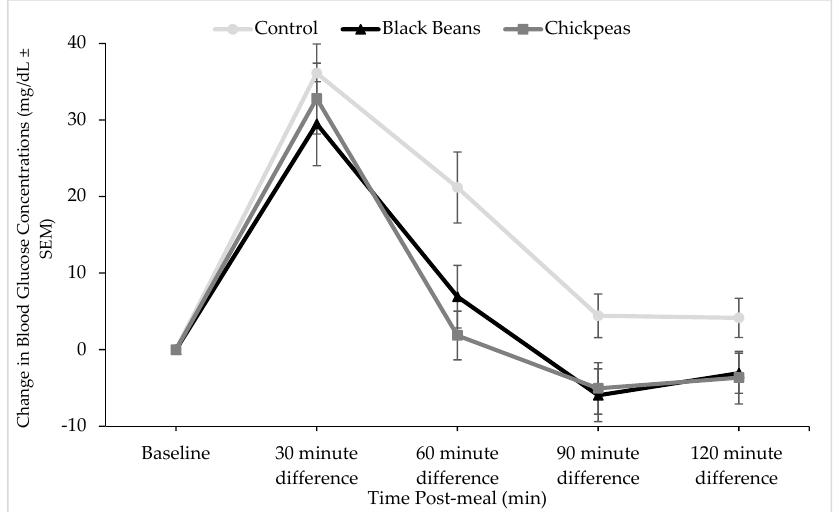
Figure 1. Effect of bean interventions on change in plasma glucose concentrations from fasting. Points denote mean glucose concentration at each data collection timepoint and error bars denote standard error of means. Mean fasting glucose values were not significantly different between treatment groups (91.68 (SEM 2.42), 89.54 (SEM 1.83), and 89.64 (SEM 5.70) mg/dL for white rice, black beans and white rice, and chickpeas and white rice, respectively). Results of a post-hoc paired t-test indicated that the glucose response curve was significantly different at 60 ( p = 0.026), 90 ( p = 0.001), and 120 ( p = 0.024) for black beans ( n = 12), and at 60 ( p = 0.024) and 90 ( p = 0.012) for chickpeas ( n = 9) compared to control (rice alone). A trend was observed at the 120 min timepoint between chickpeas and rice and the white rice control meal ( p =